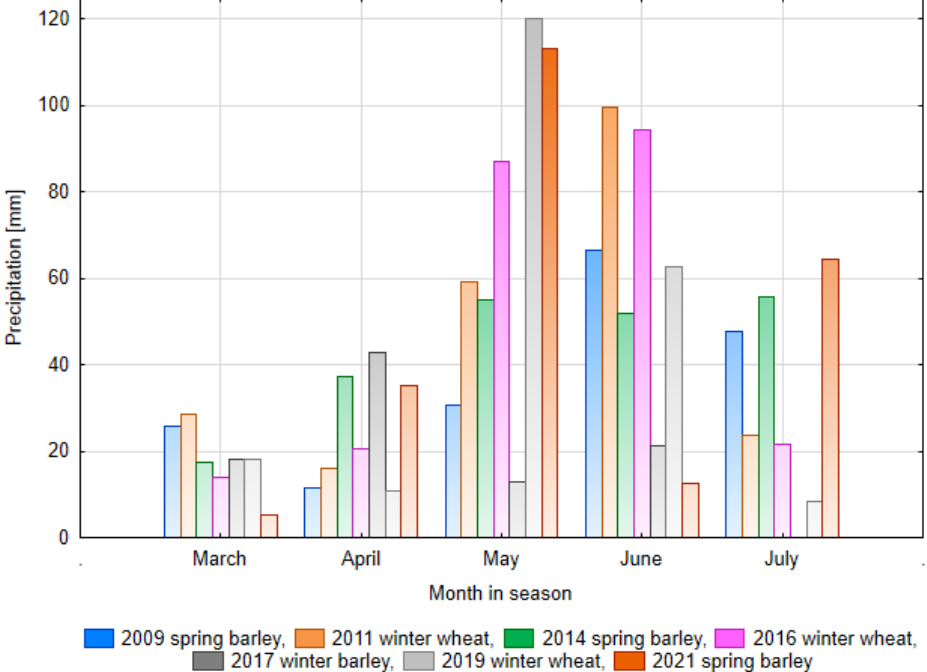
Figure 4. Monthly average precipitation throughout the assessed period of time (2009–2021) focused on the main vegetation season (March–July).